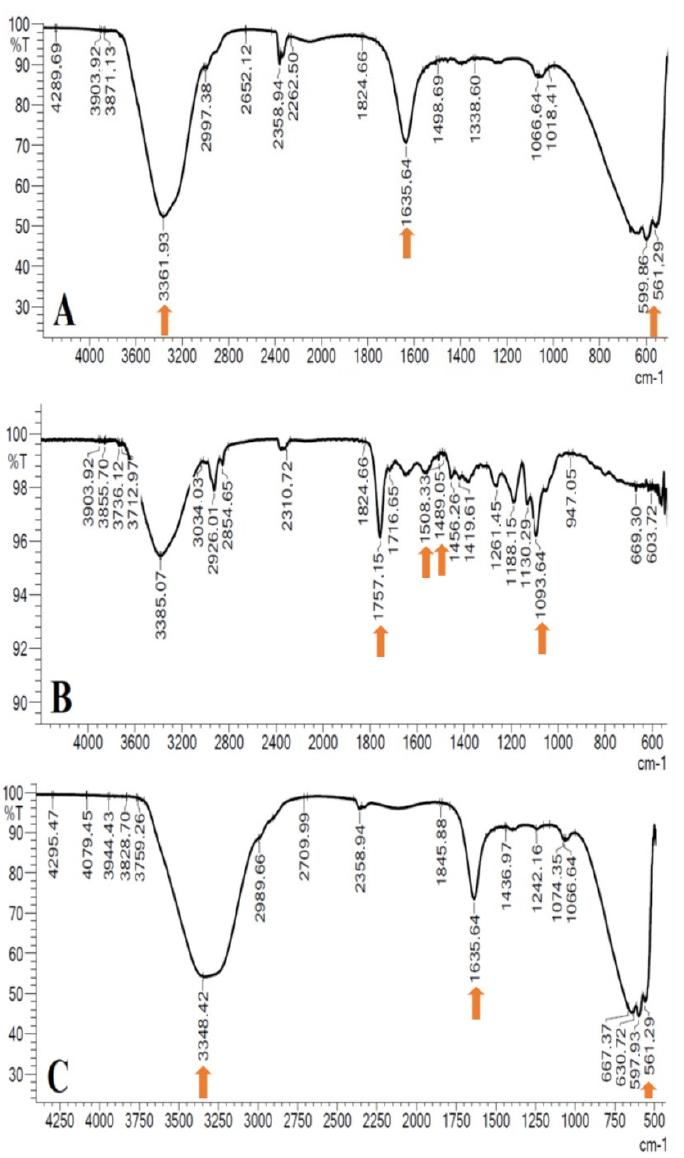
Figure 2. FTIR spectral comparison of nisin ( A ), free nisin-loaded PLGA NPs ( B ), nisin-loaded PLGA NPs ( C ) .